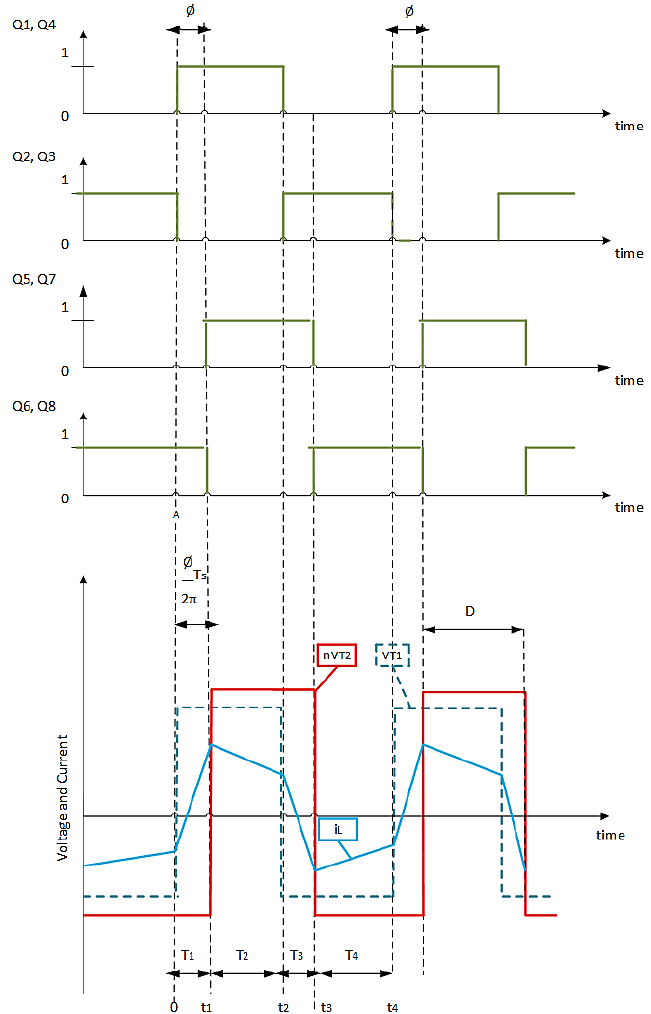
Figure 5. Voltage, inductor current, and switching signals for SPS DAB–DC/DC converter.